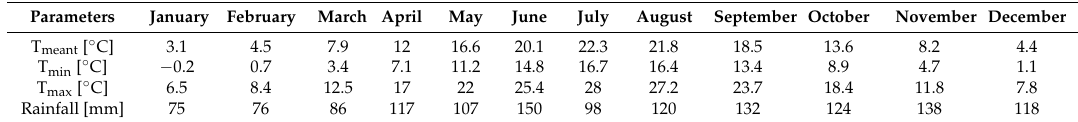
Table 6. Monthly values of temperature and precipitation about Udine.